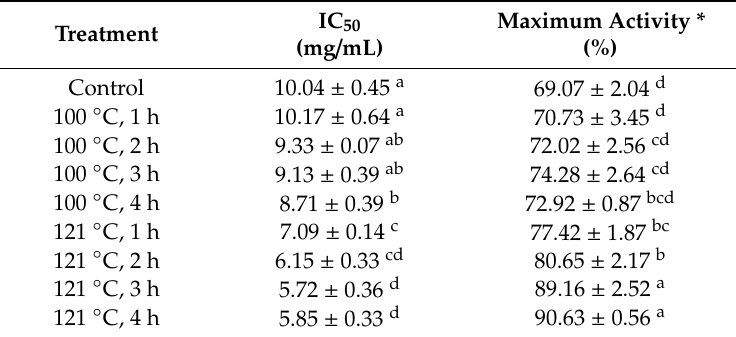
Table 4. Anti- α -glucosidase activity of